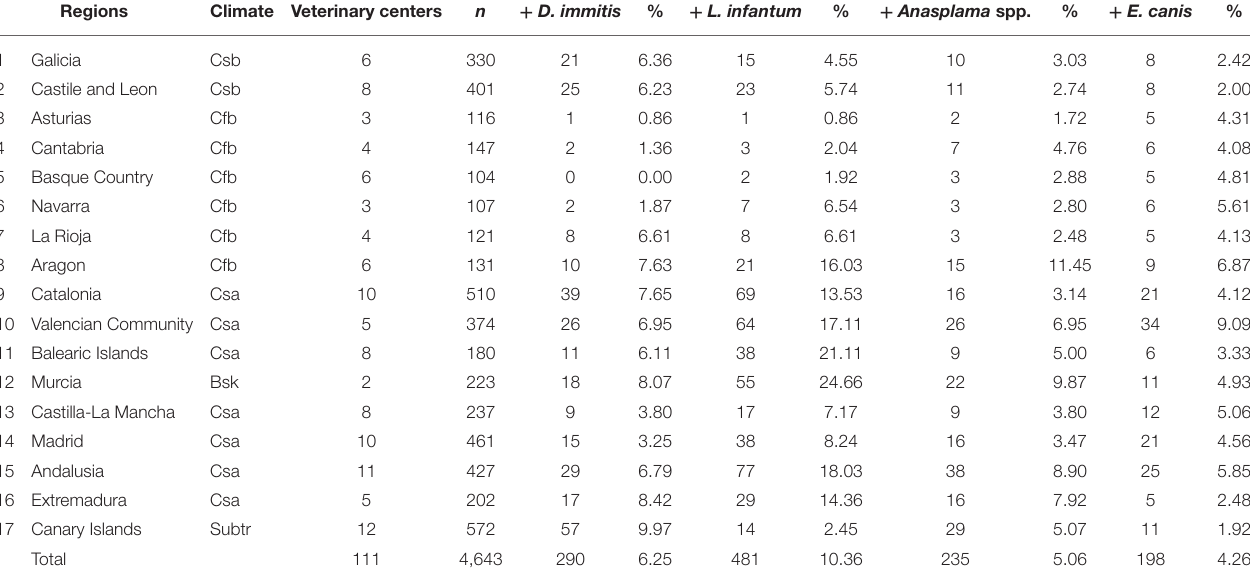
TABLE 1 | Prevalence and seroprevalences of the studied vector-borne diseases in each autonomous community in Spain.